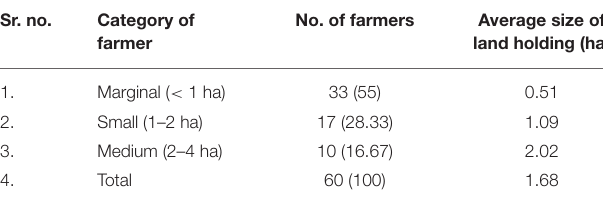
TABLE 1 | Distribution of sampled households according to their landholdings. Sr.